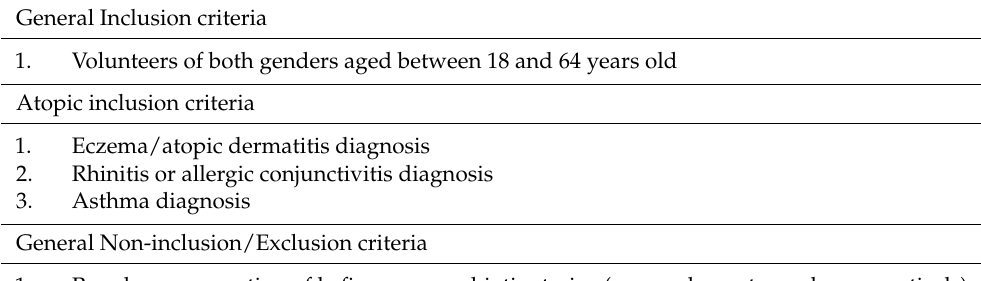
Table 1. General inclusion and exclusion criteria and atopic group specific inclusion